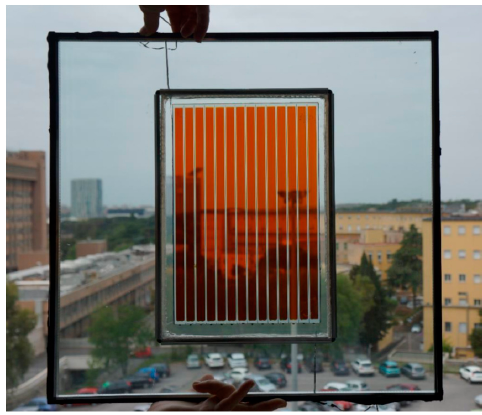
Figure 2. The glass system prototype used to test DSM with STB; the red stripes are the dye cells connected to form the dye-sensitized module.